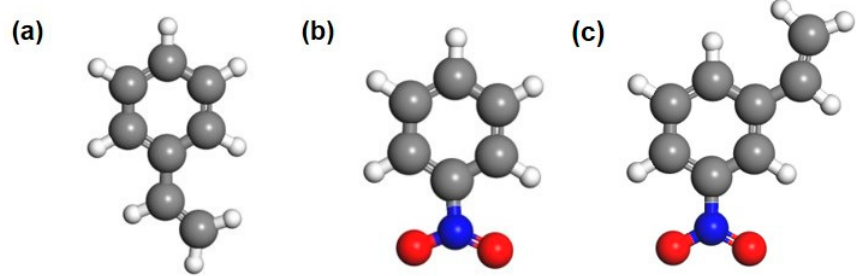
Figure 1. Molecular structures of styrene ( a ), nitrobenzene ( b ), and 3-nitrostyrene ( c ). The gray, white, red, and blue balls represent C, H, O, and N, respectively.